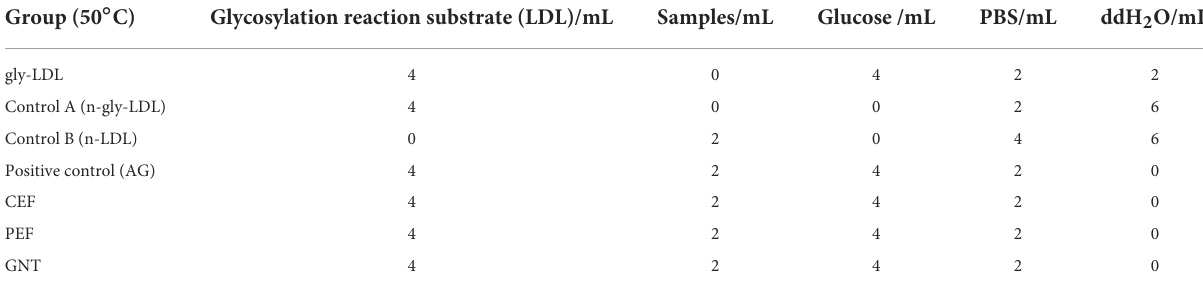
TABLE 3 Non-enzymatic glycation incubation system of low density lipoprotein. ◦ Group (50